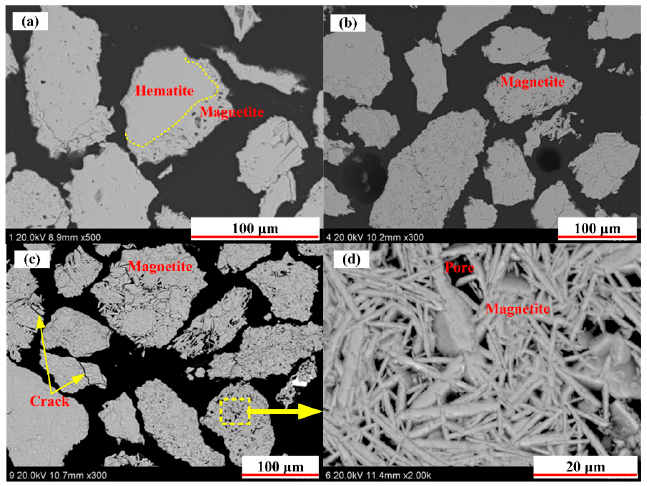
Figure 10. Microstructure of roasted samples atdifferent times at 600 °C: ( a )30 s ( α = 10%); ( b )120 s ( α = 50%); ( c ) and ( d )420 s ( α = 100%).